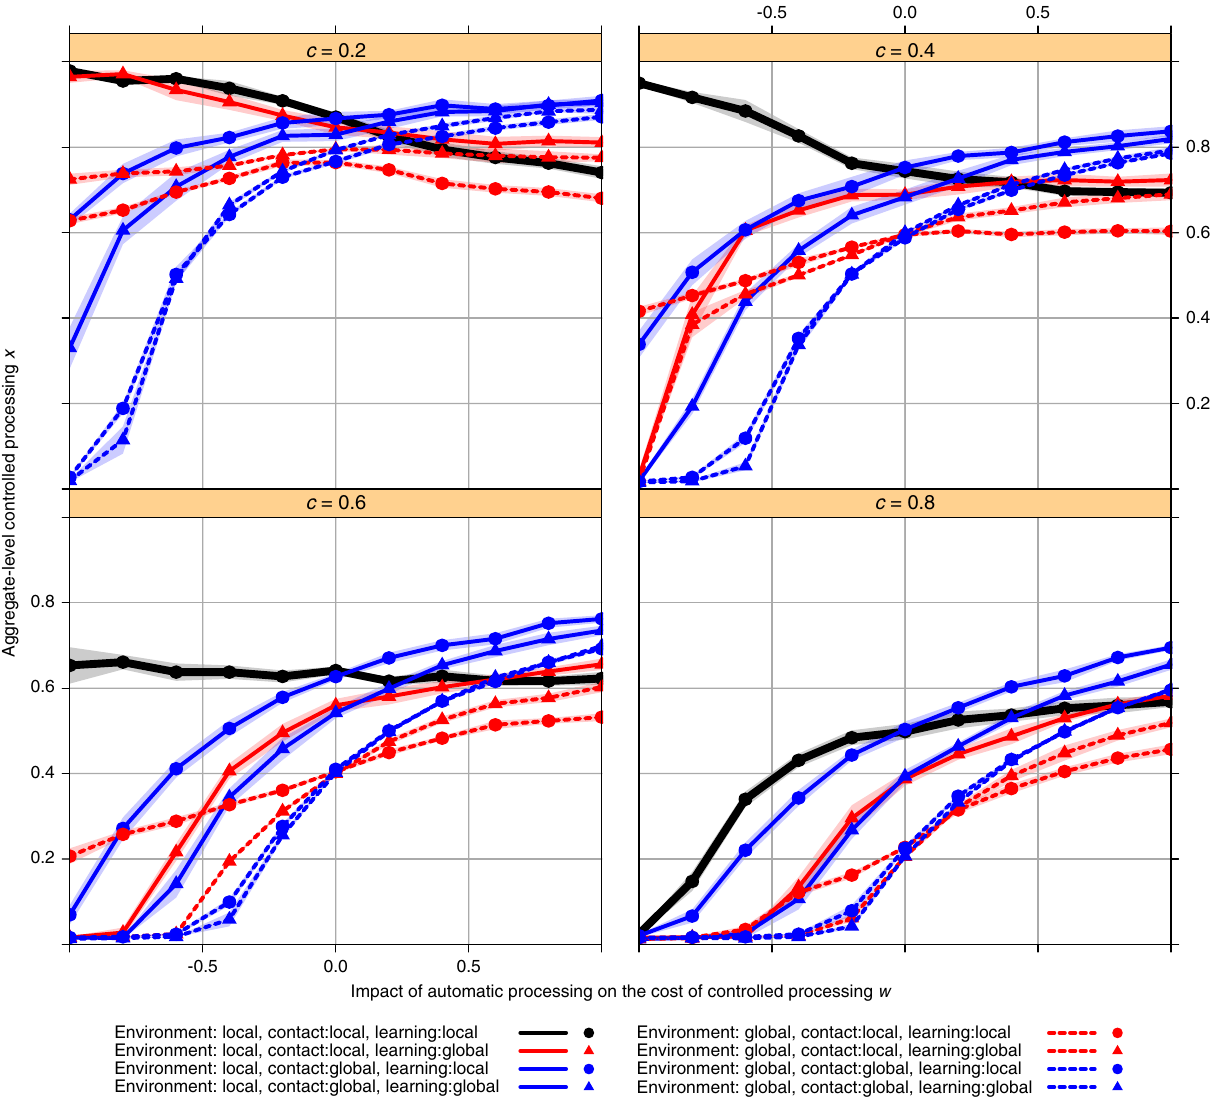
Fig. 1 Aggregate-level controlled processing x . Each line represents a combination of local versus global contact, environment, and learning, across different levels of the impact of automatic processing on the cost of controlled processing ( w ) and fi xed cost of controlled ( c ). Contact is indicated by color (red = local, blue = global). Environment is indicated by line type (solid = local, dashed = global). Learning is indicated by symbol (circle = local, triangle = global). All values are averaged over 10 simulation replicates. The shaded area represents the 95% con fi dence interval of <x> across simulation replicates for each set of parameters and combination of local versus global